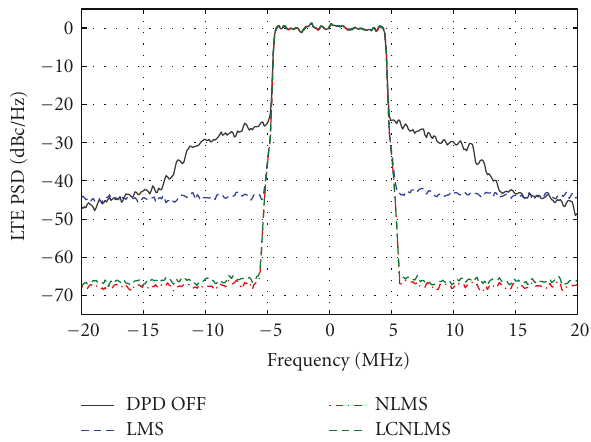
Figure 8: Convergence speed of LMS, NLMS, and LCNLMS. Figure 9: PSD performances of a complex-gain LUT predistorter trained using LMS, NLMS, and LCNLMS. Input signal is 10MHz LTE